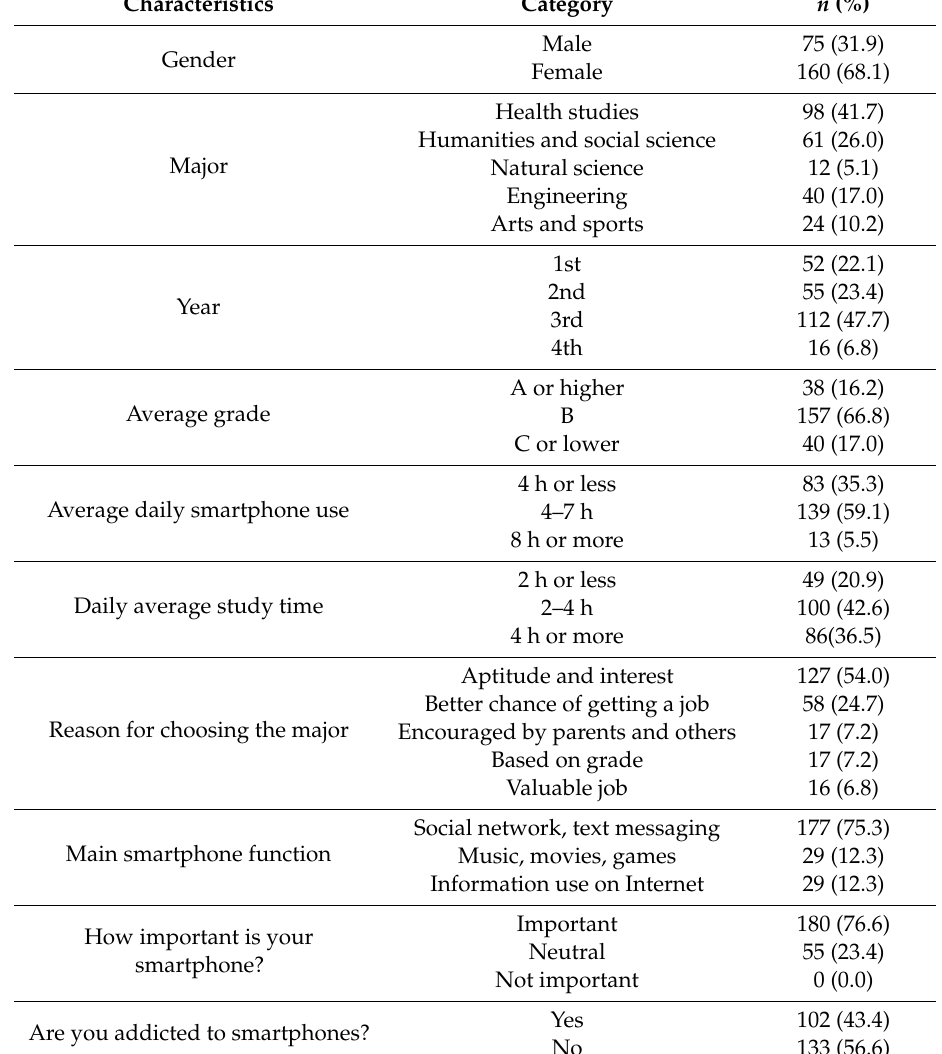
Table 1. Participant’s general characteristics ( n = 235).